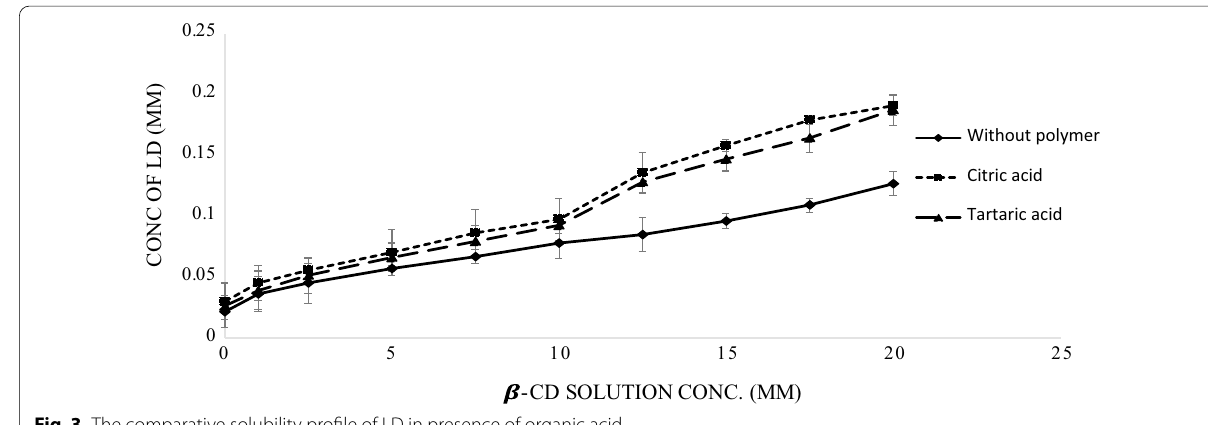
Fig. 3 The comparative solubility profile of LD in presence of organic